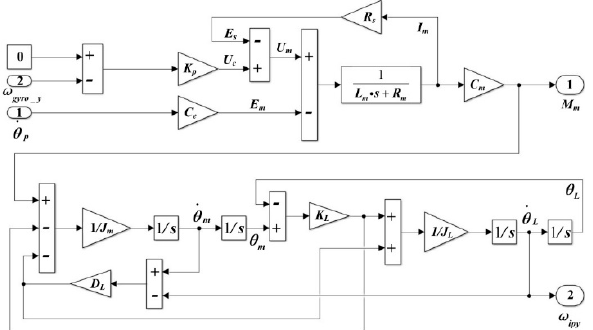
Figure 8. Simulation module of the pitch motor.